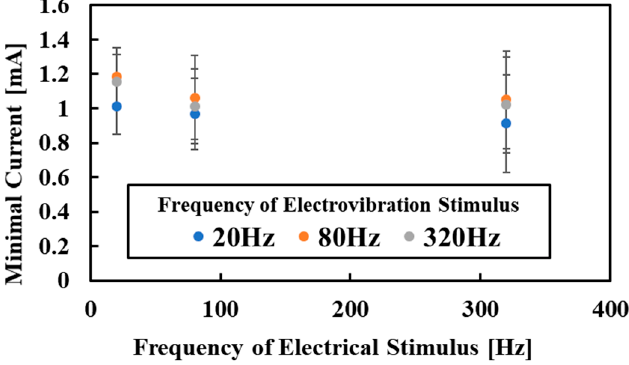
Figure 9. Experimental results for multiple tactile stimuli. Multiple tactile stimuli were perceived by the subjects. The frequency dependence of the perception on the electrical stimulus was smaller than that of the single electrical stimulus.